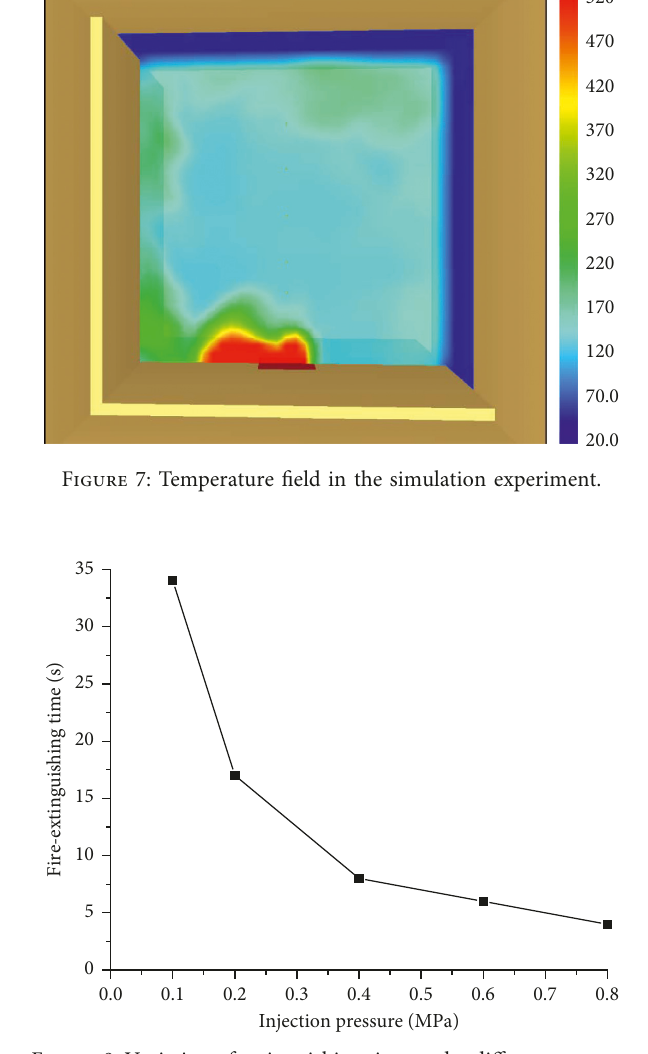
Figure 8: Variation of extinguishing time under different pressure